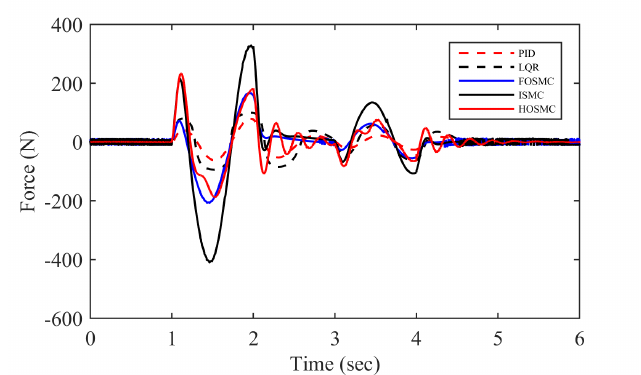
Figure 10. Control